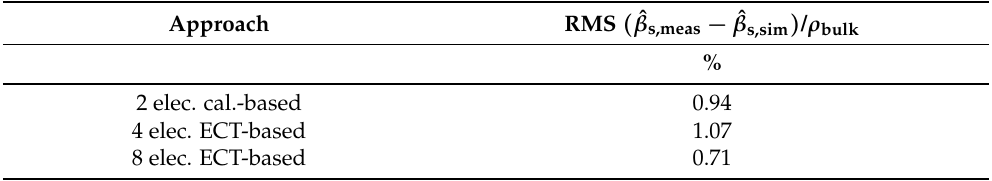
Figure 11. Comparison between the holistic model and measurement experiments for sensors with different numbers of electrodes. Table 3. Quantitative comparison between the average trend of the simulated estimates ˆ β s,sim and the estimates ˆ β s,mean of the measurement experiments (see Figure 11) for sensors with different numbers of